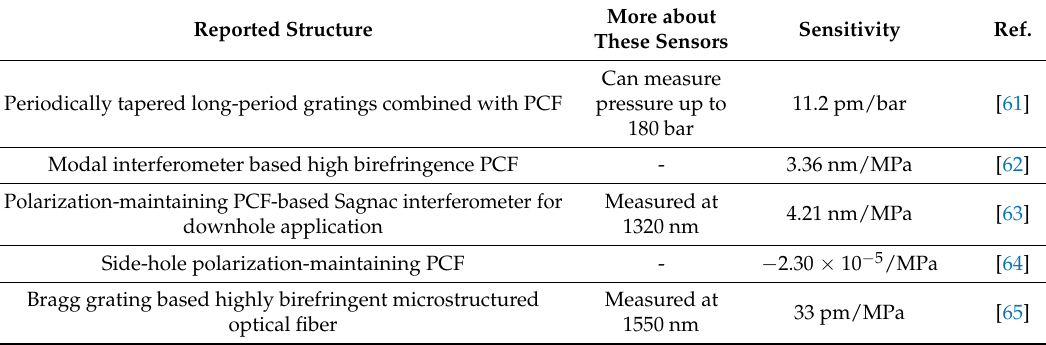
Table 2. Comparative representation of different PCF-based pressure sensors.